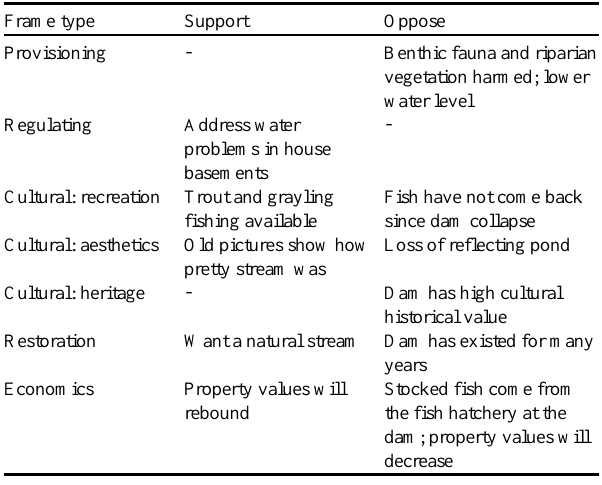
Table 3. Arguments supporting or opposing dam removal made in comments by online newspaper readers in the Tallåsen, Sweden, dam removal case.